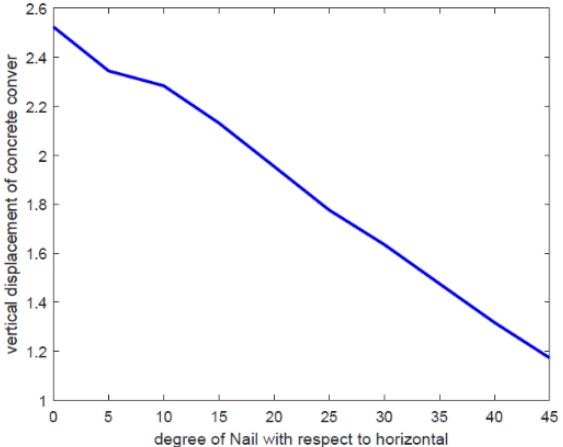
Figure 19. Effects of nail orientation on the vertical plaster displacement.